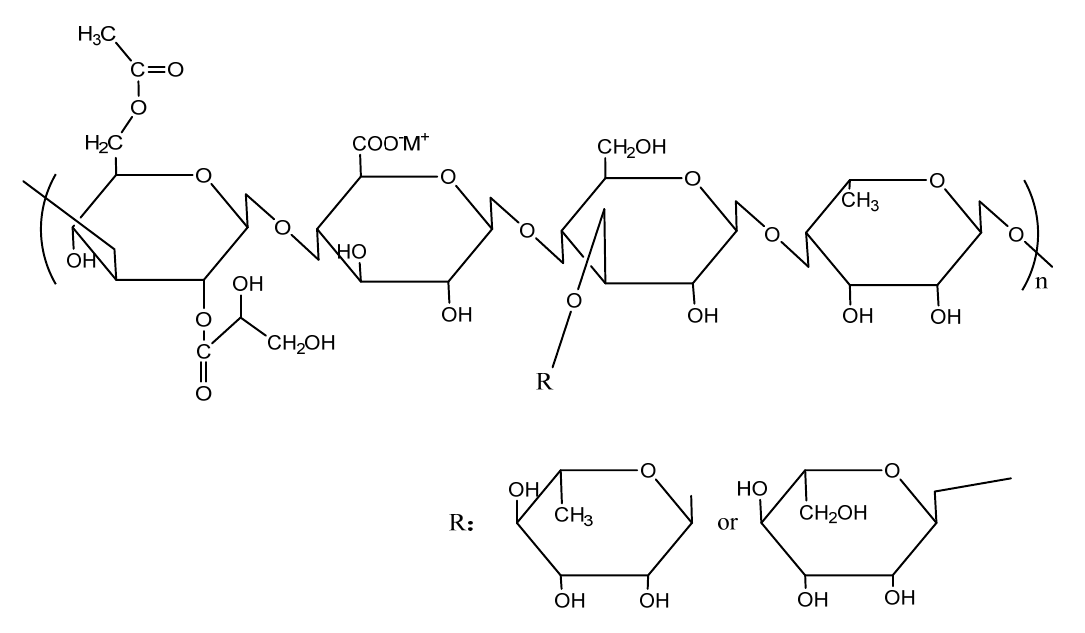
Figure 1. Molecular structure of welan gum.